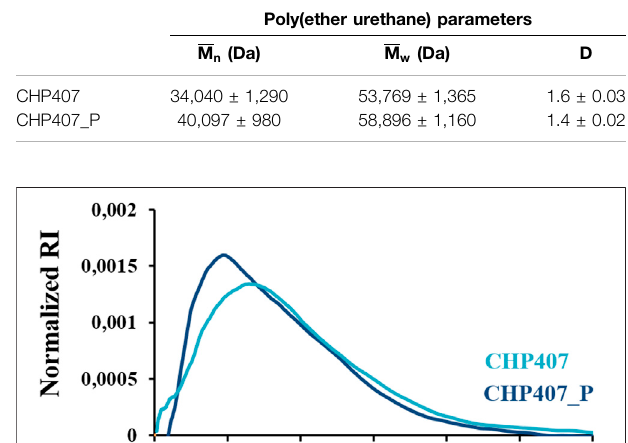
( Table 1 ): the removal of PEO-PPO diblocks in the macrodiol